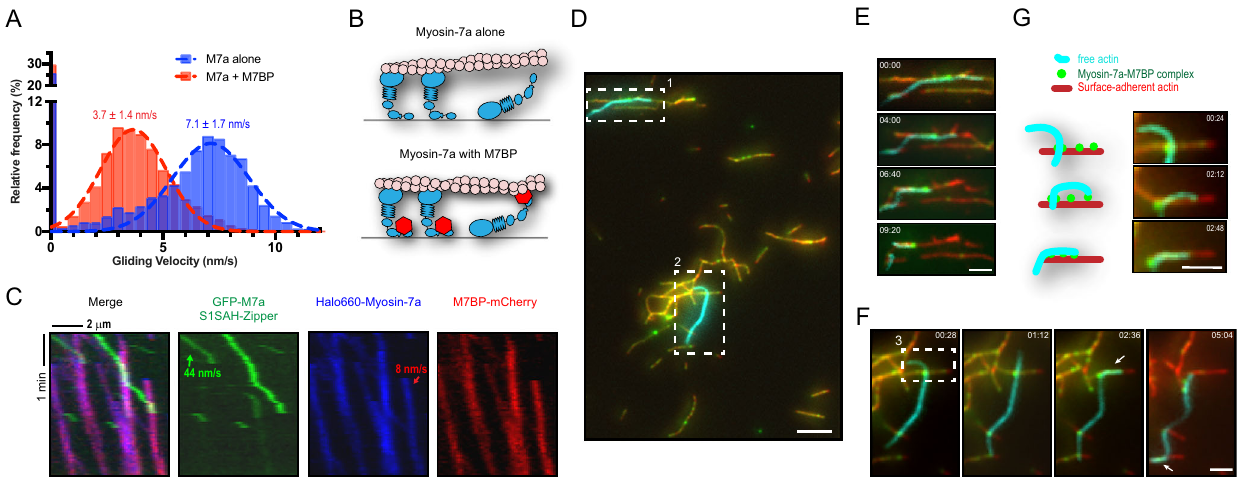
Fig. 4 M7BP tethers actin fi laments and enables myosin-7a-M7BP complex to drive actin- fi lament alignment in vitro. A Speed distribution of actin movement by ensembles of surface-immobilized myosin-7a in the absence or presence of M7BP. N = 6044 actin fi laments for myosin alone over four independent experiments. N = 7467 actin fi laments for myosin with M7BP over four independent experiments. B Cartoon diagrams how infused M7BP tethers actin fi laments and reduces the actin gliding speed. C Motilities of GFP-myosin-7a zippered dimer (green) and the myosin-7a-M7BP complex (shown in blue and red for myosin-7a and M7BP respectively) on the same actin fi laments (unlabeled). Note that the zippered dimer of myosin-7a moves faster. D – G Myosin-7a-M7BP complexes tether actin fi laments and actively drive them into alignment. Myosin-7a-M7BP complex is visualized by a GFP tag on myosin-7a (green). Immobilized actin fi laments are labeled with Rhodamine-phalloidin (red) and free actin fi laments labeled with Alexa-647 phalloidin (cyan). D A TIRF fi eld view shows free actin fi laments were bound to the surface by myosin-7a complexes. Scale bar = 5 μ m. E Free actin fi laments were transported by myosin complexes while they were moving along immobilized fi laments (region of box 1 in D ). F The two ends of a free actin fi lament were driven into alignment with surface-immobilized fi laments against deformation strain (white arrow, region of box 2 in D ). G Time-lapse images and cartoons showing that a free actin- fi lament end was caught by myosin-7a complexes, which caused the fi lament to bend and to align with the immobilized fi lament that the myosin was walking on (magni fi ed time-lapse images of box 3 in F ). Scale bars = 2 μ m applied to E – G